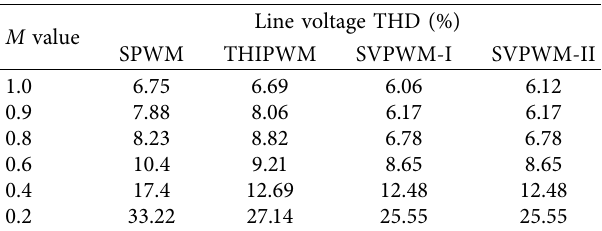
Figure 10: 11L CHB inverter line voltage for dynamic values of M . (a) SPWM. (b) THIPWM. (c) SVPWM-I. (d) SVPWM-II. Table 8: Line voltage THD at various values of M .